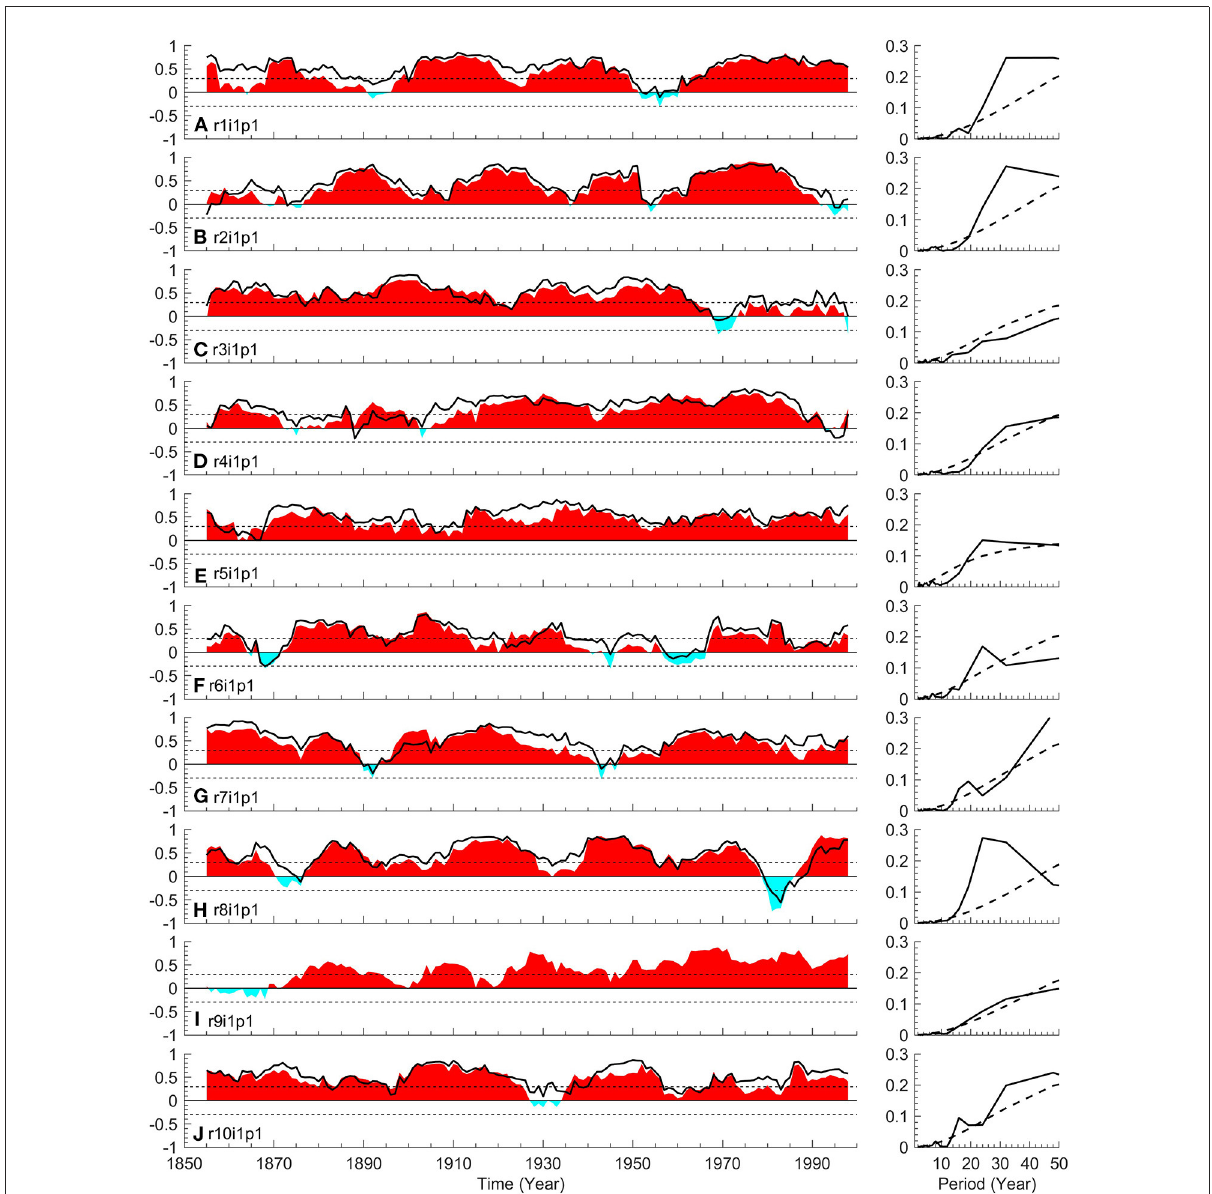
FIGURE11 Lag correlation between the STIO SSTA/SSHA in fall and the SSTA/SSHA in the Niño3.4 area in the following fall with a running window of 11 years in different ensemble members in the CNRM-CM5 historical simulations. Shading and curves indicate correlation of SSTA and SSHA, respectively. The horizontal axis shows window central date. (Right panels) show corresponding power spectral of each ensemble members, dashed lines indicate the 95% significance level of the power spectra